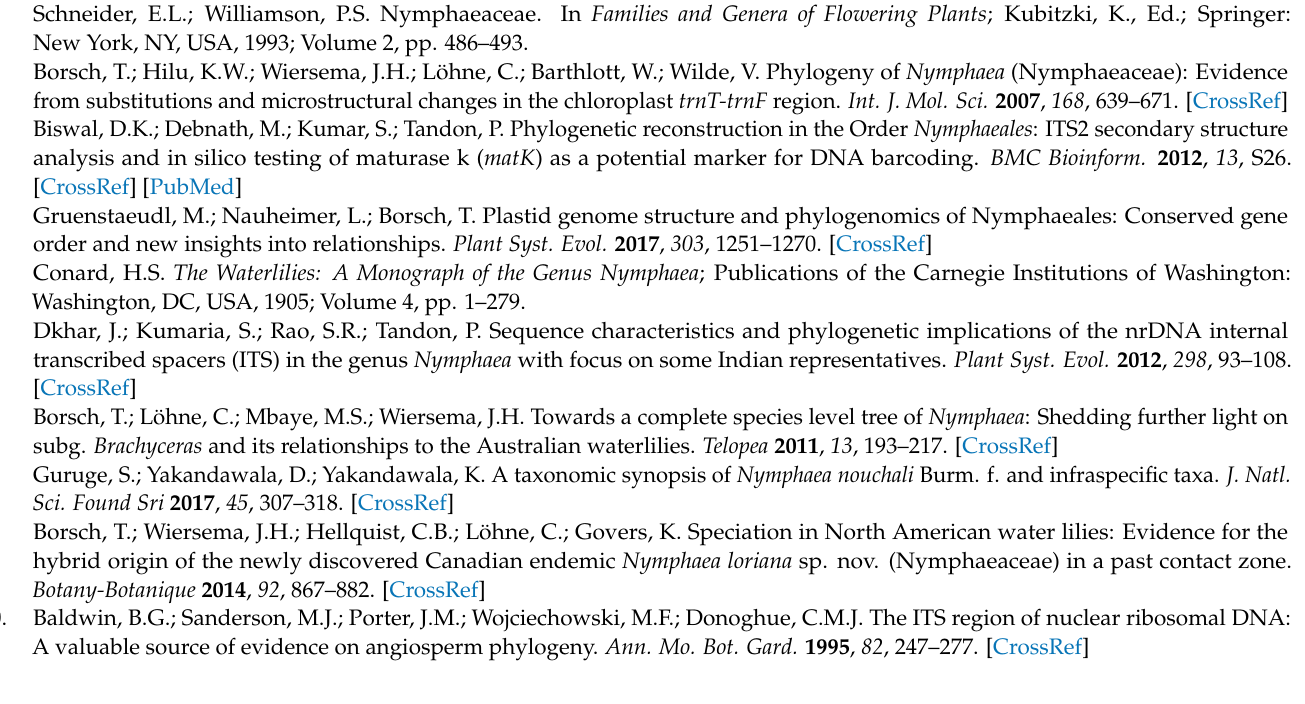
Figure S3: rpl16 partition strategy through the ASAP algorithm. Figure S4: trnT-trnF+rpl16 partition strategy through the ASAP algorithm. Figure S5: Phylogenetic tree constructed based on 167 trnT- trnF sequences of Nymphaea . Figure S6: Phylogenetic tree constructed based on 164 rpl16 sequences of Nymphaea . Figure S7: Phylogenetic tree constructed based on 152 trnT-trnF+rpl16 sequences of Nymphaea . Table S1: Sample information of African Nymphaea . Table S2: The results of species identification using the BLAST search from GenBank. Table S3: The identification results based on the phylogenetic analysis. Table S4: The species identification results of African Nymphaea . Table S5: Primer name and sequences of DNA barcoding. Table S6: Downloaded sequences from GenBank in this